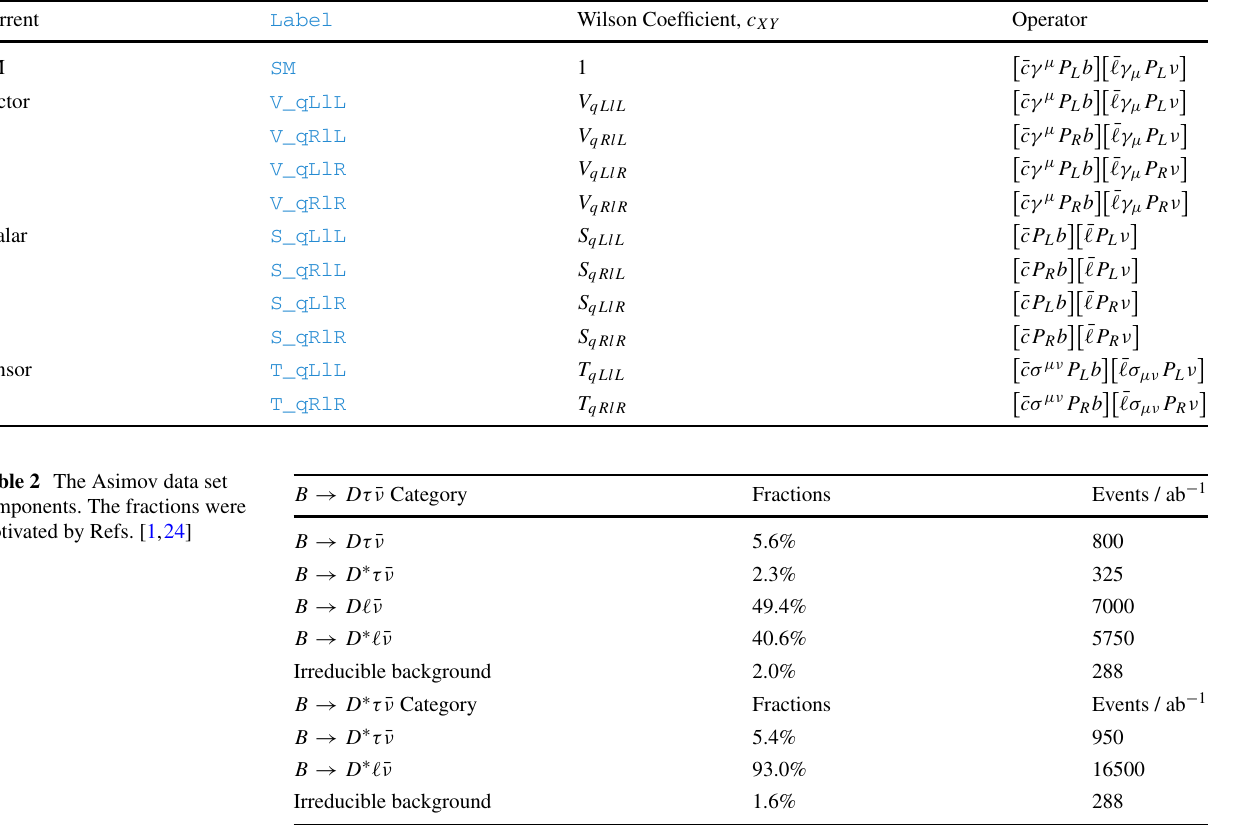
Table 1 The b → c (cid:8)ν operator basis and coupling conventions. Also shown are the identifying Wilson coefficient labels used in Hammer . The normalization of the operators is as in Eq. (2) Current